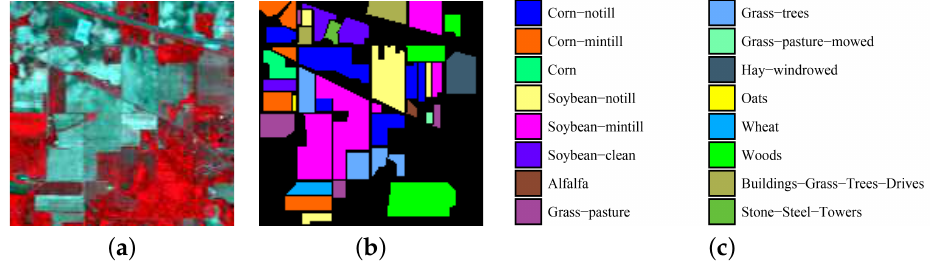
Figure 3. Indian Pines dataset. ( a ) False-color composite; ( b , c ) Ground-truth data.